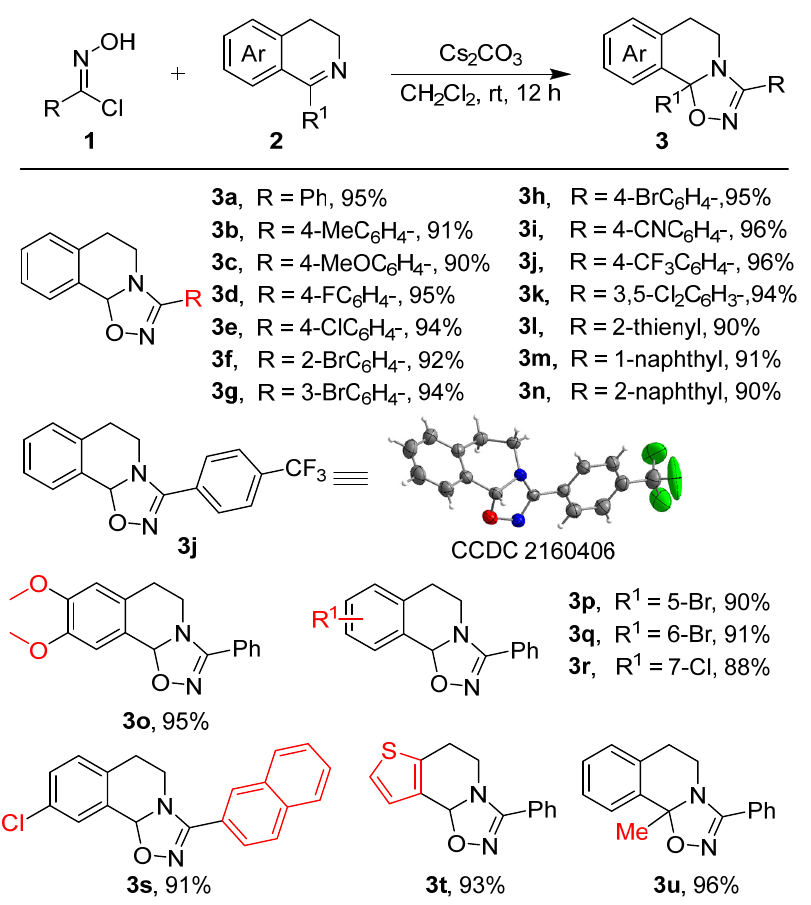
Figure 2. Substrate scopes for the formation of O-acylhydroxamate 3 . Reaction conditions : oxime chlorides 1 (0.22 mmol), cyclic imines 2 (0.2 mmol), Cs 2 CO 3 (0.22 mmol), CH 2 Cl 2 (1 mL), at room temperature for 12 h. Yield of the isolated product.